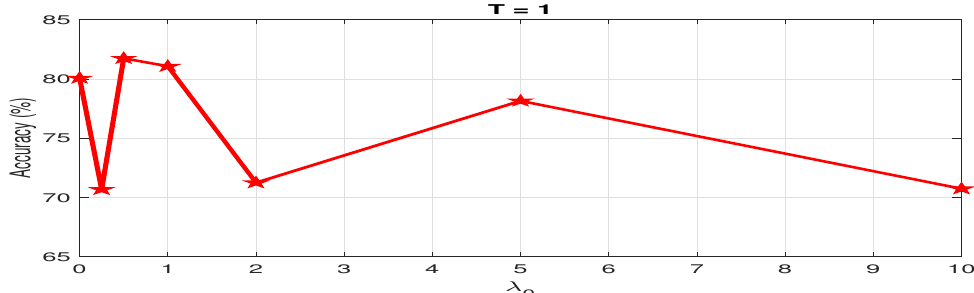
Figure 6. Comparison of accuracies of various values of λ o for temperature parameter T = 1 using the Adam optimizer on the LCF-15 dataset.